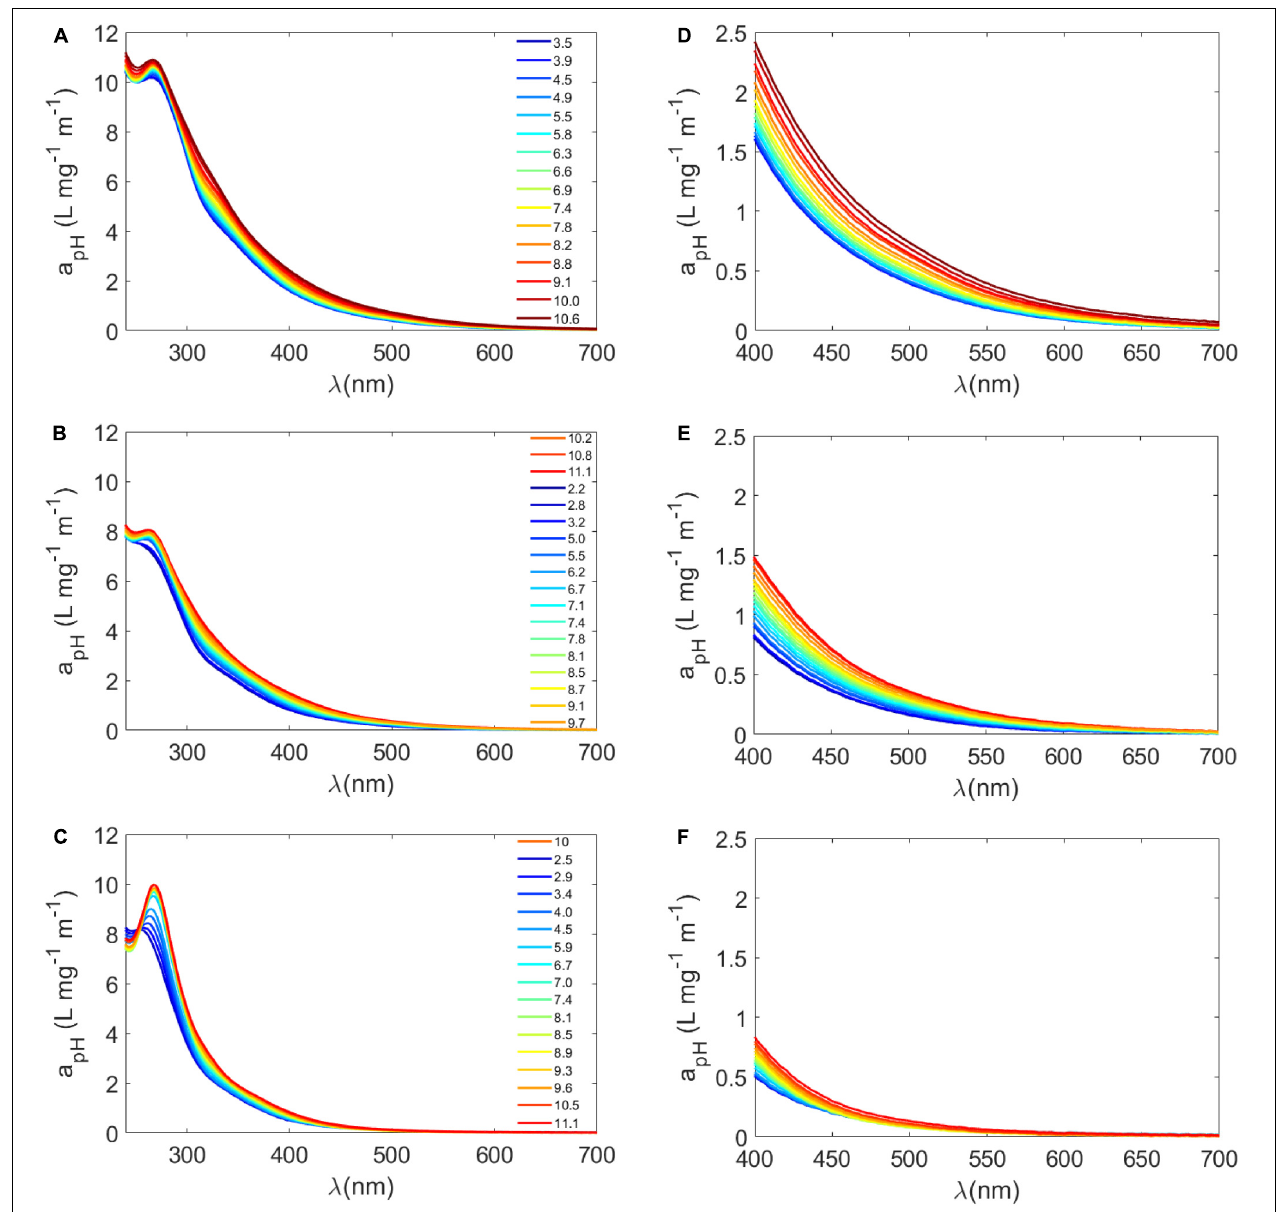
FIGURE 3 | (A–C) Mass-normalized absorption spectra ( a pH = a ( λ )/DOC, L mg − 1 m − 1 ) plotted from 240 to 700 nm for a Sargassum SPE-DOM sample that underwent various treatments followed by pH titration: (A) no treatment (“untreated”), (B) photodegraded (“irradiated”), and (C) reduced with NaBH 4 (“reduced”). Colors from blue to red represent different pH values from low pH (blue) to high pH (red), with select pH values listed from ∼ 3 to 11. (D–F) the same mass normalized a pH ( λ ) spectra plotted in the visible from 400 to 700 nm where (D) is untreated, (E) is irradiated, and (F) is